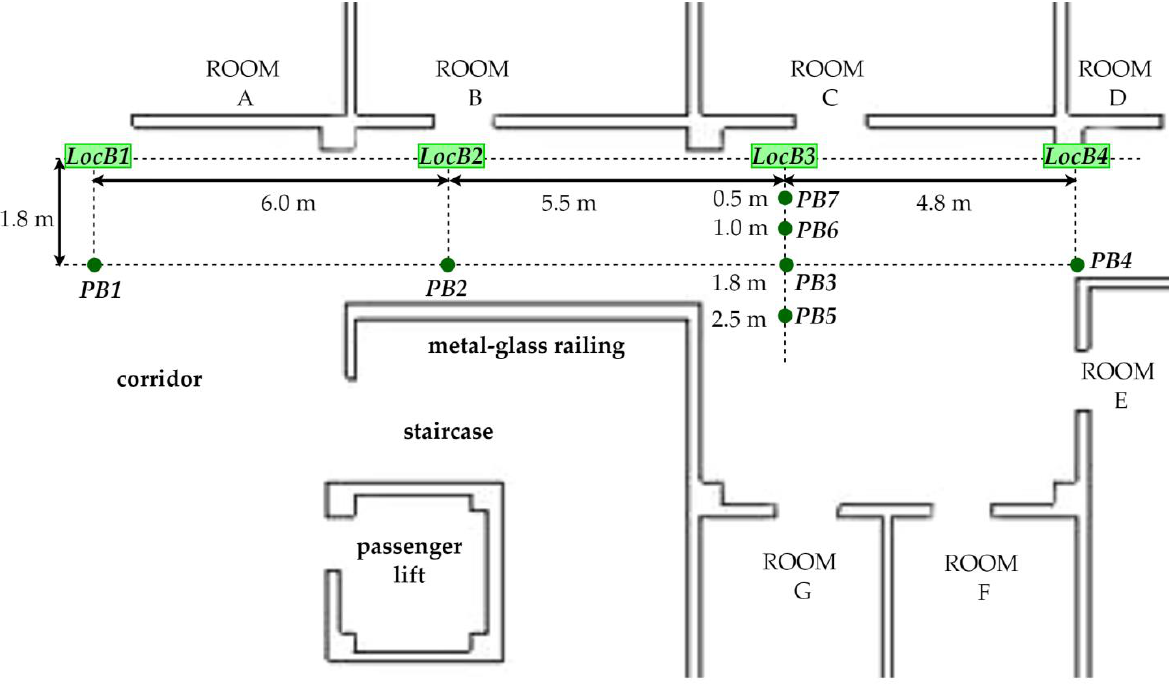
Figure 3. Situation sketch showing the mutual placement of locator nodes ( LocB1 , LocB2 , LocB3 , LocB4 ) and object locations ( PB1 , PB2 , … , PB7 ) in Stage B